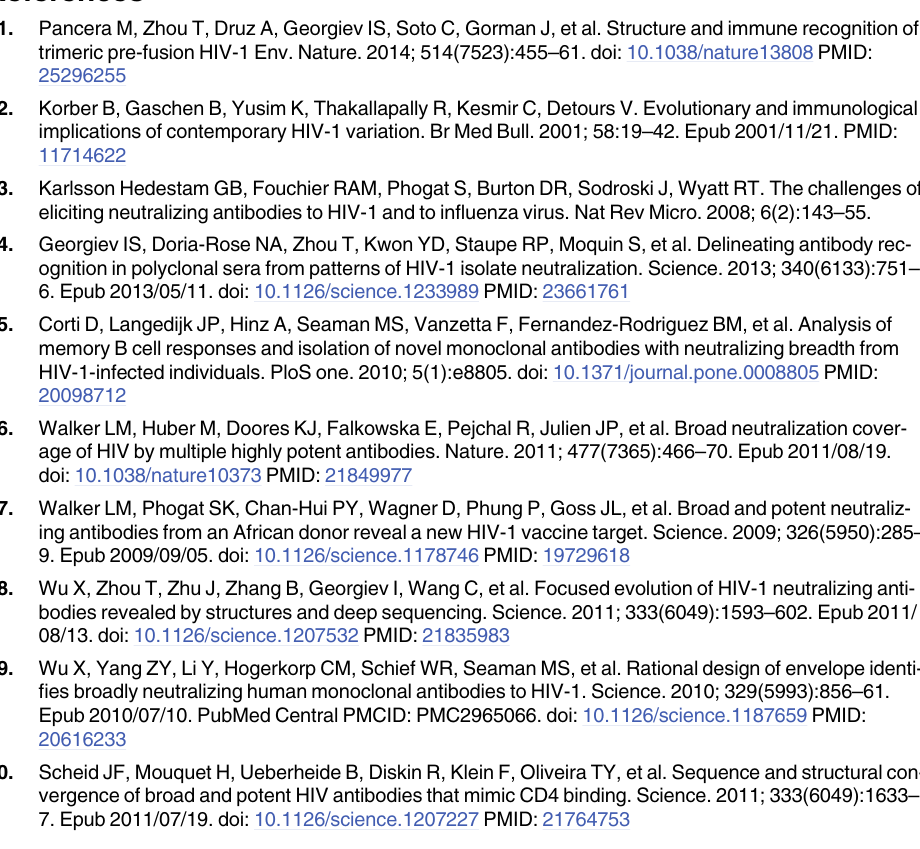
S10 Fig. Serum delineation accuracy of top 5,000 virus panels of size 20 on a test set of sera that does (x-axis) or does not (y-axis) include bNAb clonal